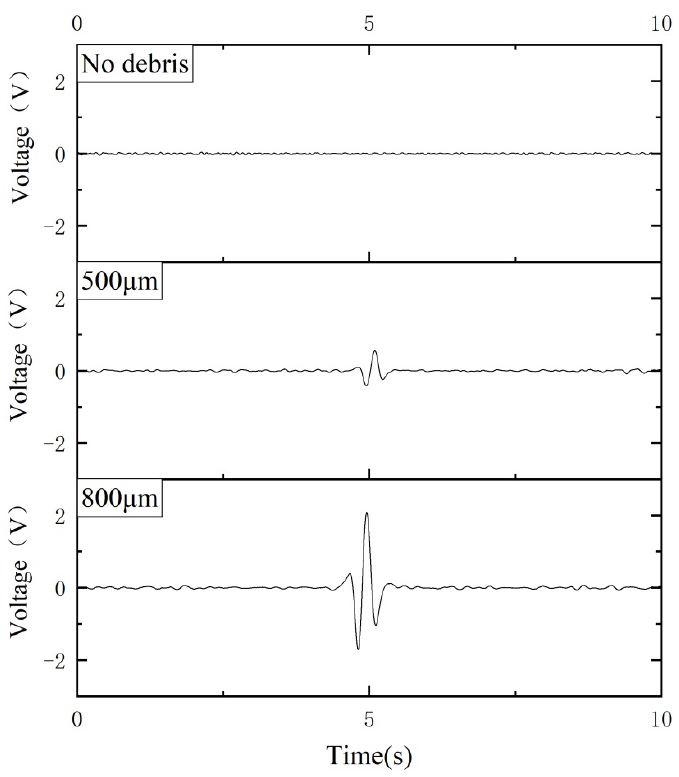
Figure 15. Voltage signals are generated by the passage of nonferrous metal debris of different diameters.